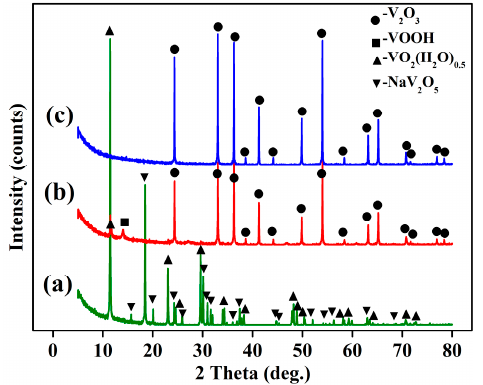
Figure 9. XRD patterns of the powders obtained at ( a ) 0.5 h, ( b ) 1 h and ( c ) 2 h.